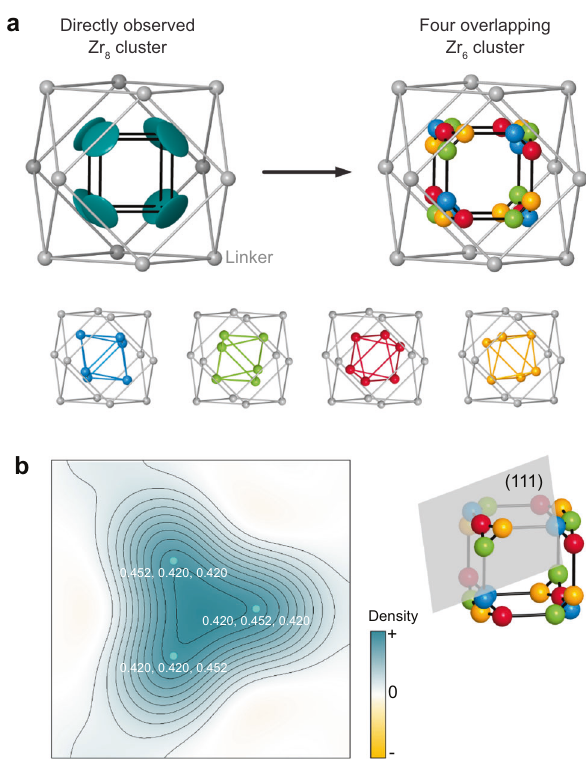
Fig. 4 Cluster orientations from single-crystal X-ray diffraction (SCXRD). a Zr 8 cluster (teal) determined from SCXRD data, with a fl at disk-shaped ellipsoid of the Zr atom (left) and a truncated cube created by the overlap of four different orientations of Zr 6 O 4 (OH) 4 clusters (blue, green, red, and orange), each occupied by 25% (right); b Fourier map of the (111) plane through the truncated corners of the cube showing the electron density map of three Zr atoms (positions indicated in orientations are related by 90° rotations around the crystal- lographic axes (Fig. 4a). Overlapping these four Zr 6 clusters adds up to a truncated cube (corner-to-corner distance = 2.70 Å ) with a strong resemblance to the Zr 8 O 6 cluster structure published for PCN-221 (Zr – Zr = 2.69 Å ). Using this disoriented model, the R value was improved by 12%, compared to the structure model